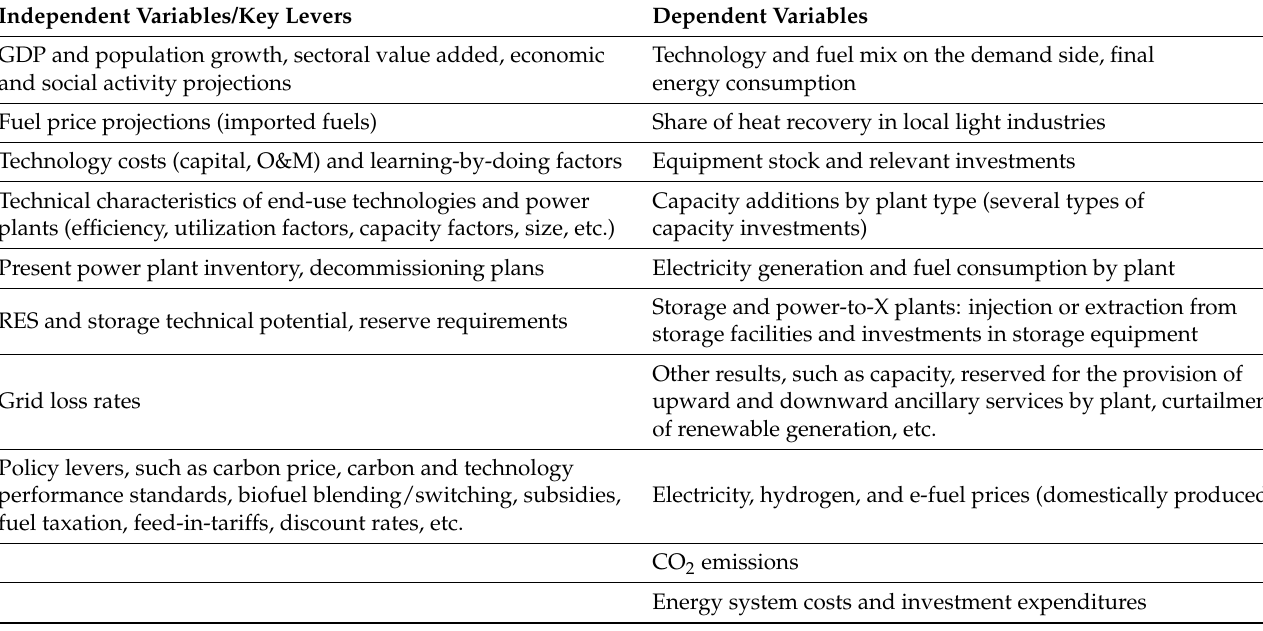
Table 4. Independent and dependent variables of the scenario analysis as well as key levers